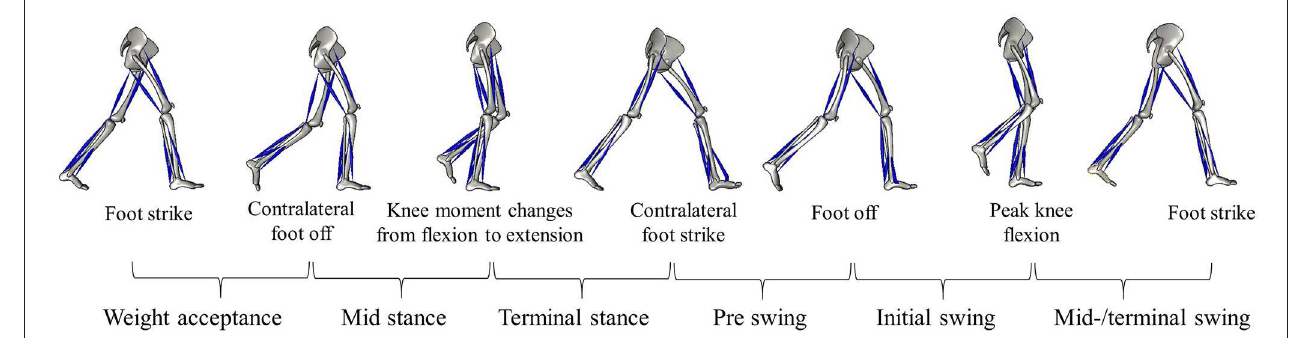
FIGURE 1 | Illustration of a complete gait cycle with the right leg’s events, separating the six gait phases: weight acceptance, midstance, terminal stance, preswing, initial swing, midswing/terminal swing.